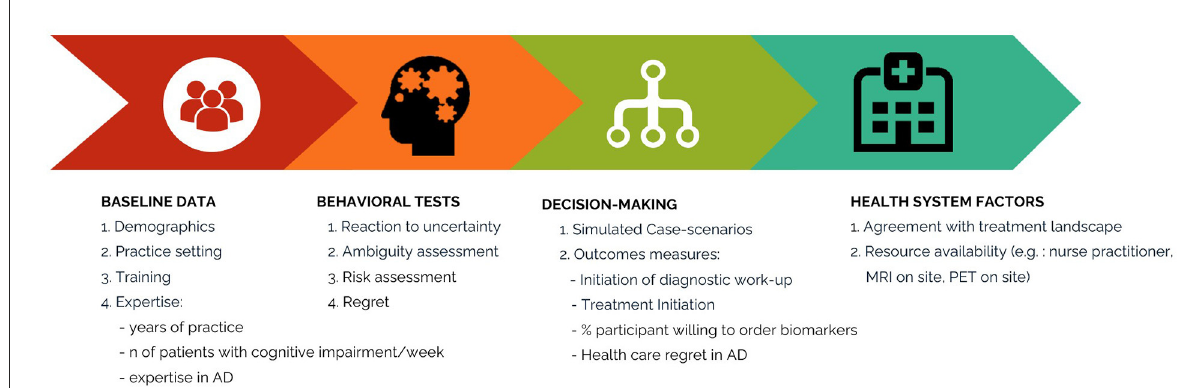
FIGURE2 Flow of the proposed study. This figure illustrates the study flow. Participants start by completing information on demographics, medical education, and clinical experience, then behavioral tests to determine their risk preferences and subsequently 10 simulated case-scenarios related to common clinical encounters in the diagnosis and management of patients with dementia and AD. Finally, they will answer questions related to their current practice and